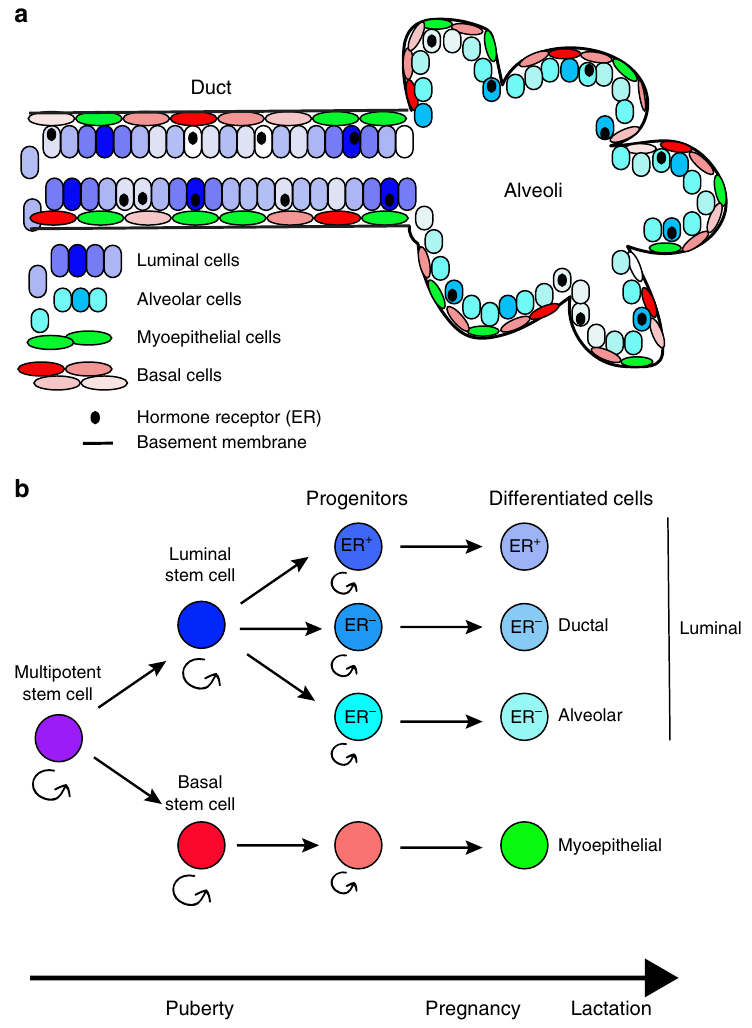
Fig. 1 Simplistic model of mammary epithelial cell differentiation hierarchy. a Schematic outline of a ductal-alveolar unit with location of the various cell types indicated. b A putative map of mammary epithelial cell differentiation. A multipotent stem cell present during development gives rise to luminal epithelial and basal stem cells, which further divide into luminal and basal progenitors during puberty. Ductal and alveolar hormone-receptor negative progenitors are distinct lineages and there is also a separate hormone receptor positive luminal